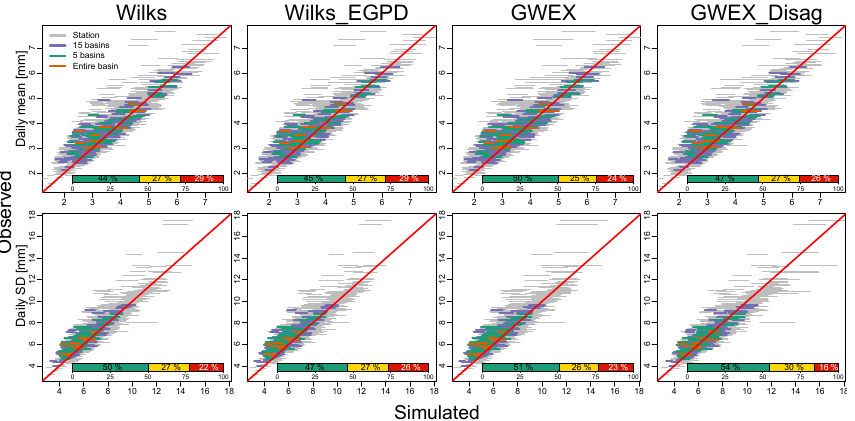
Figure 11. Daily amounts for all spatial scales and months: inter-annual mean (top) and standard deviation (SD, bottom). The 90% proba- bility limits are shown. Overall performance is represented by the indicated percentages of good, fair, and poor performance for all spatial scales and